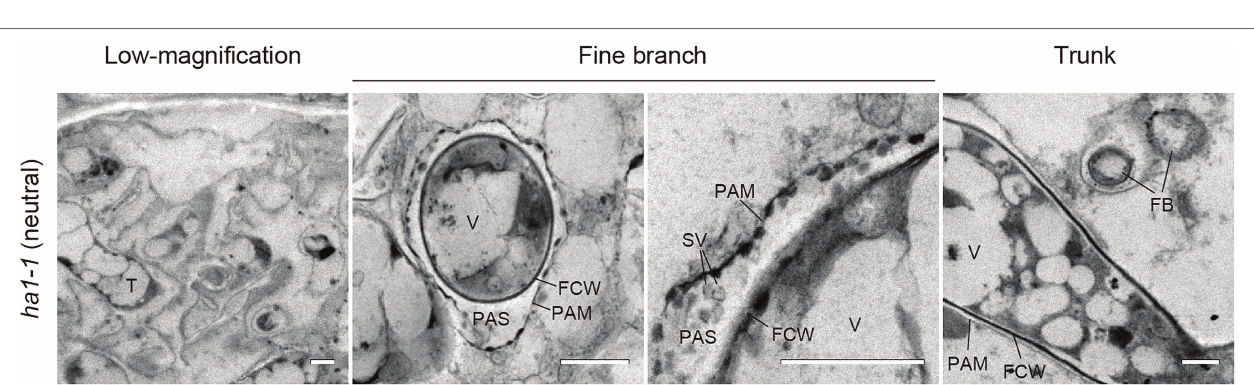
FIGURE 7 | Electron microscopic enzyme cytochemistry of neutral phosphatase (NTP) activity. Transmission electron micrographs showing NTP activity in arbuscule-containing cortical cells of the ha1-1 roots colonized by R. irregularis . NTP activity was detected as black precipitates of the reaction product (cerium phosphate) by incubating mycorrhizal roots in Tris-HCl buffer (pH 7.4) containing β -glycerophosphate and cerium chloride. Fine branches and trunk hyphae of an arbuscule colonized in a cortical cell are shown. FB, fine branch; FCW, fungal cell wall; PAM, periarbuscular membrane; PAS, periarbuscular space; SV, small vesicle; T, trunk hypha; and V, vacuole. Scale bars = 500